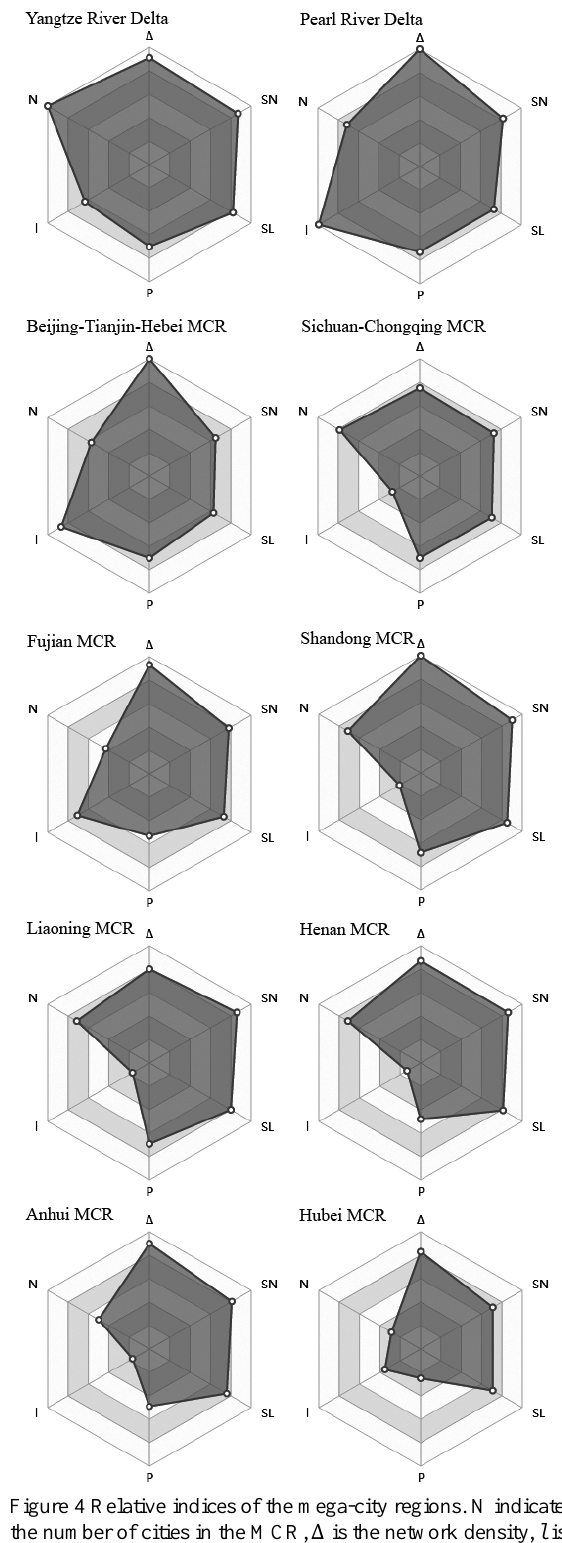
Figure 4 Relative indices of the mega-city regions. N indicates the number of cities in the MCR, is the network density, l is the connection intensity, P is the polycentricity, SL is the edge ∆ symmetry, SN is the node